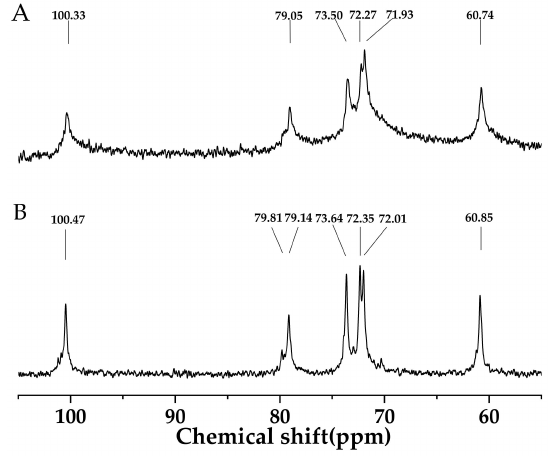
Figure 1. ( A ) 13 C NMR spectrogram of arrowroot starch treated at 45 ◦ C and ( B ) 13 C NMR spectro- gram of arrowroot starch treated at 85 ◦ C. Here, deuterated dimethyl sulfoxide (DMSO- D 6 ) was used as the solvent.